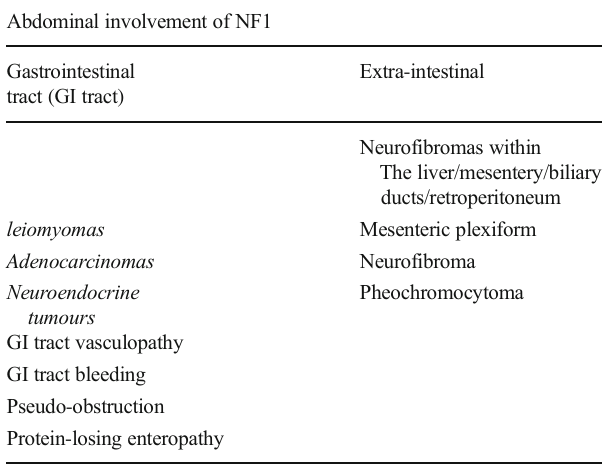
Abdominal involvement of NF1 Gastrointestinal tract (GI